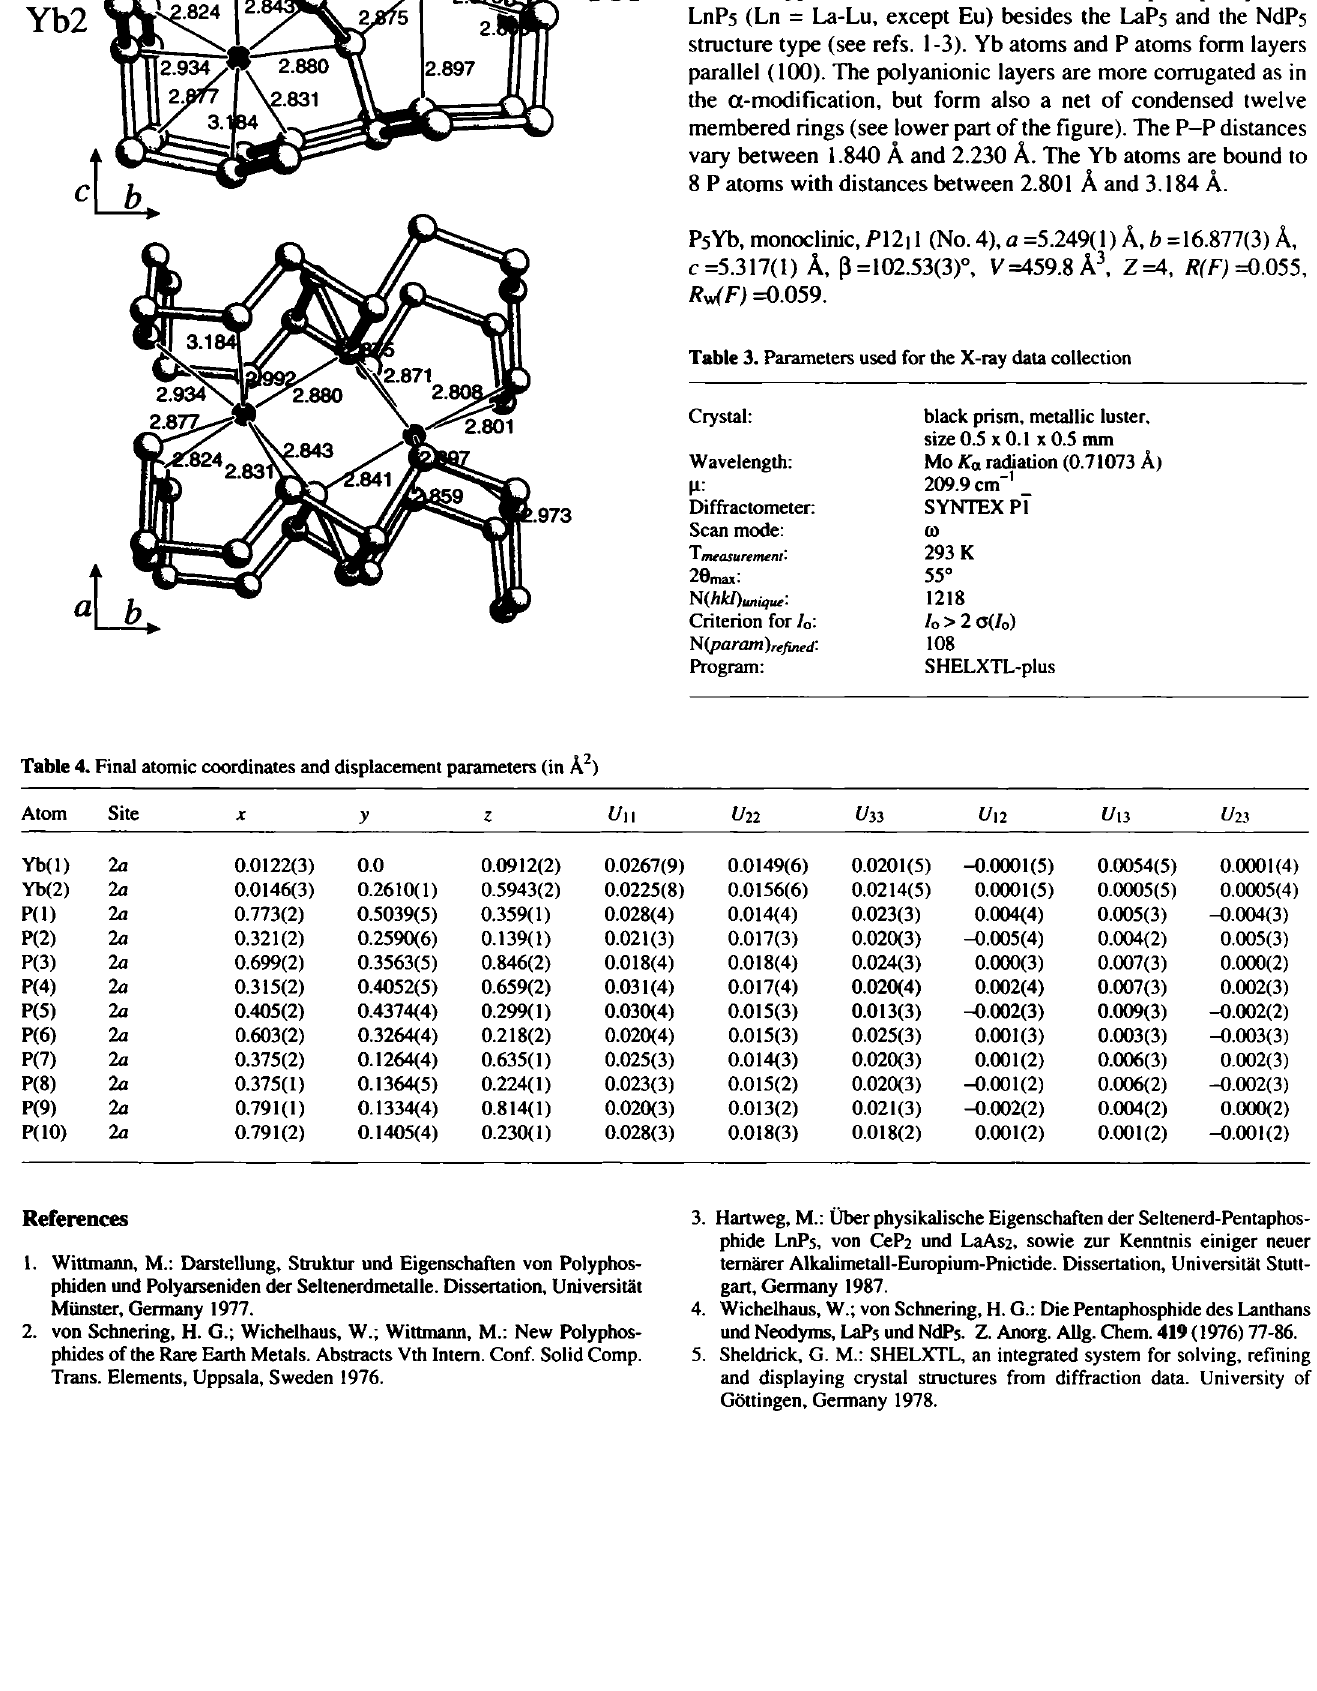
Table 3. Parameters used for the X -ray data collection